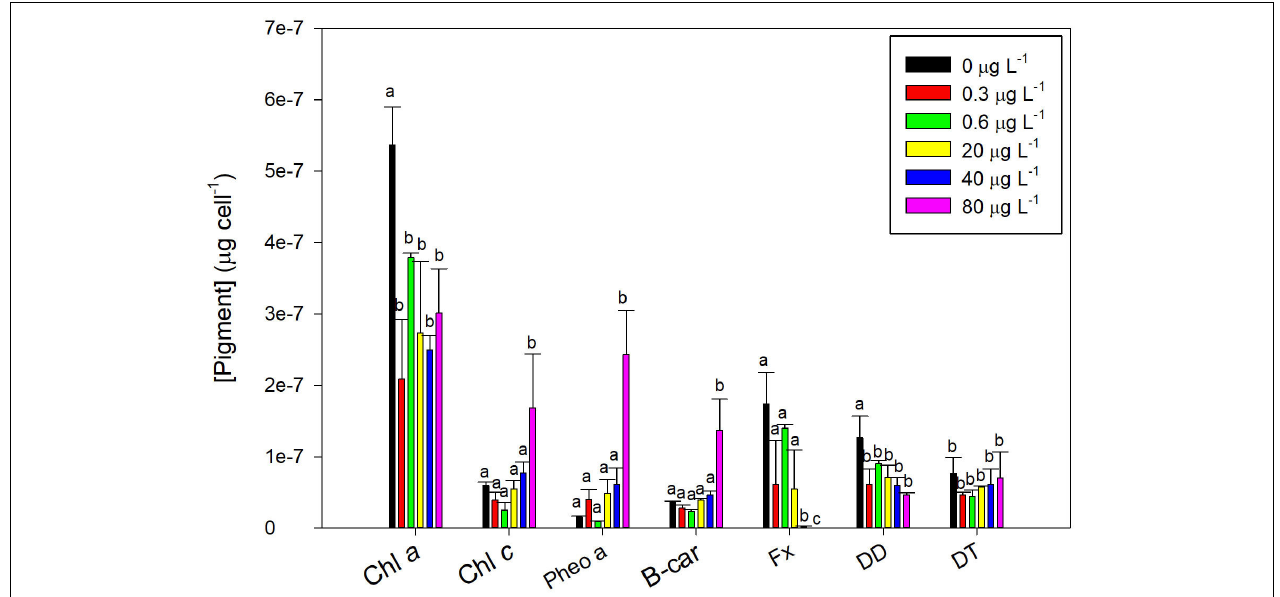
FIGURE 5 | Phaeodactylum tricornutum pigment profile following a 48 h exposure to different fluoxetine concentrations. Pigments include chlorophyll a (Chl a ), chlorophyll c (Chl c ), pheophytin a (Pheo a ), β -carotene (B-car), fucoxanthin (Fx), diadinoxanthin (DD), and diatoxanthin (DT) content. Average ± standard deviation, N = 3, different letters indicate significant differences at p <